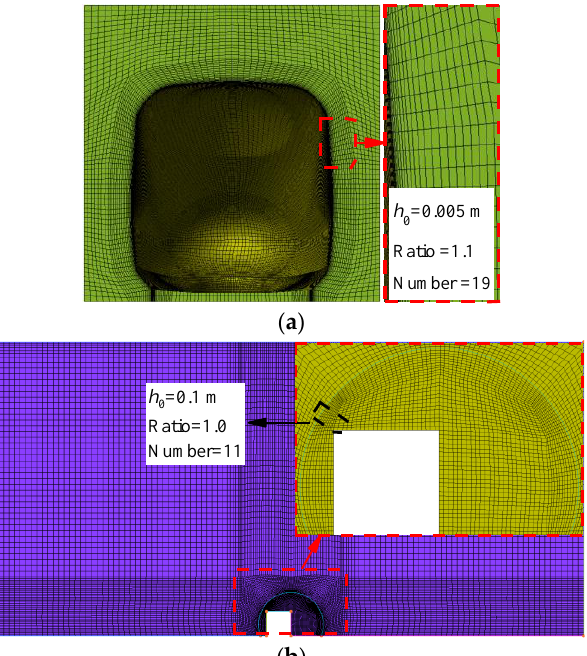
Figure 6. Surface meshes around train nose and tunnel portal. ( a ) Surface mesh of train nose; ( b ) Surface mesh of tunnel portal.